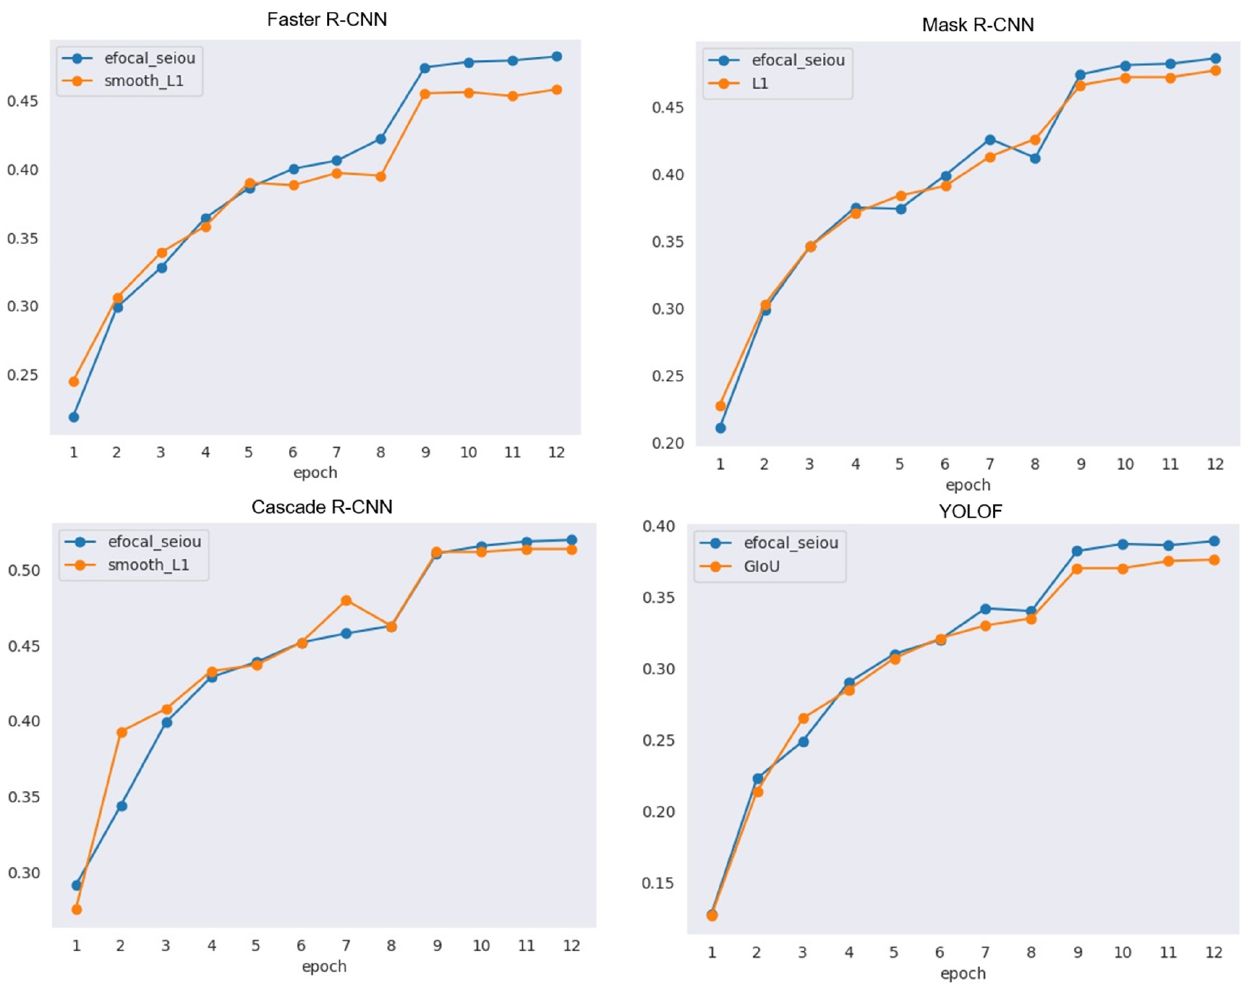
Figure 9. Comparison chart of AP trend.